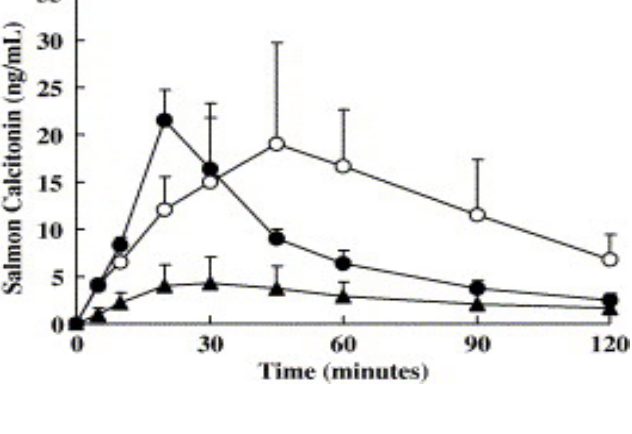
Figure 5. Comparison of plasma concentration–time profiles following nasal administration of liquid and powder formulations, and subcutaneous administration ( ○ ) of 0.3 mg of sCT in